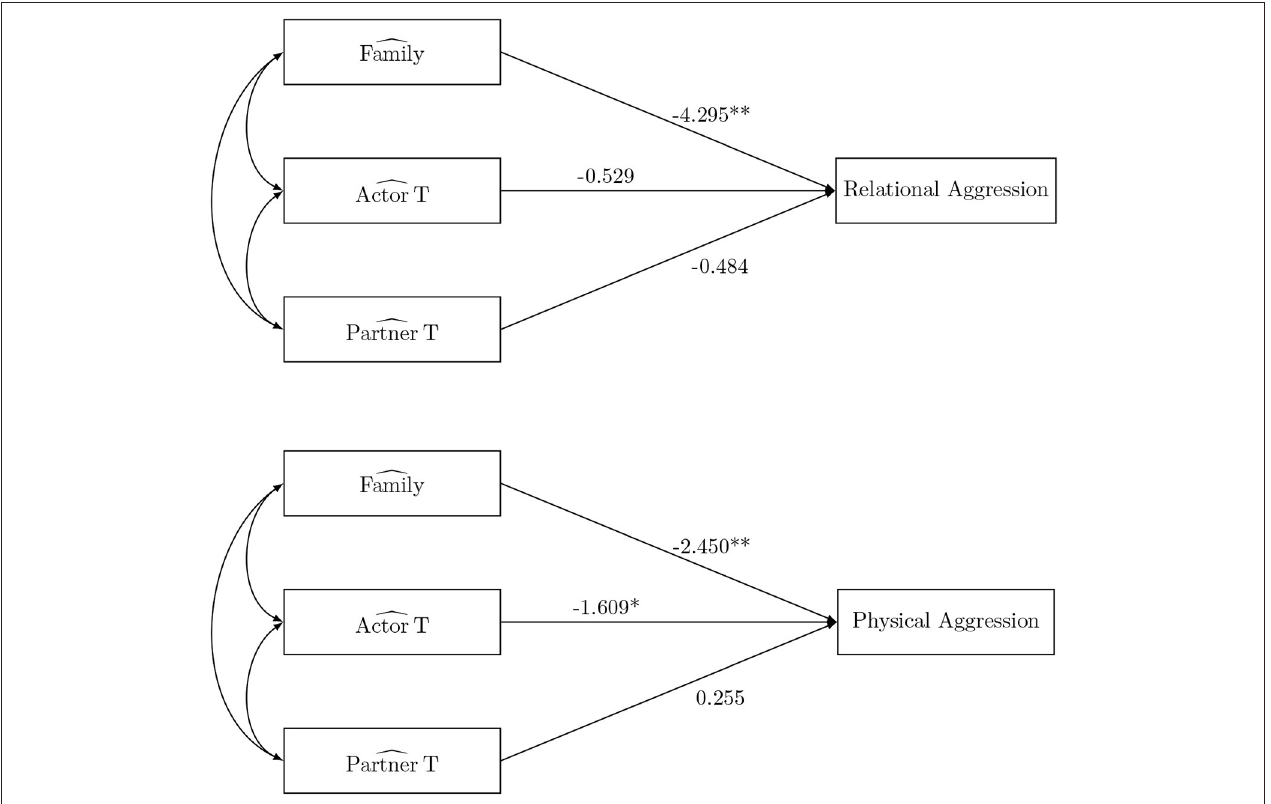
FIGURE 2 | The social relations model components as predictor in the naive ANOVA analysis. * p < 0.05, ** p < 0.01, and *** p <